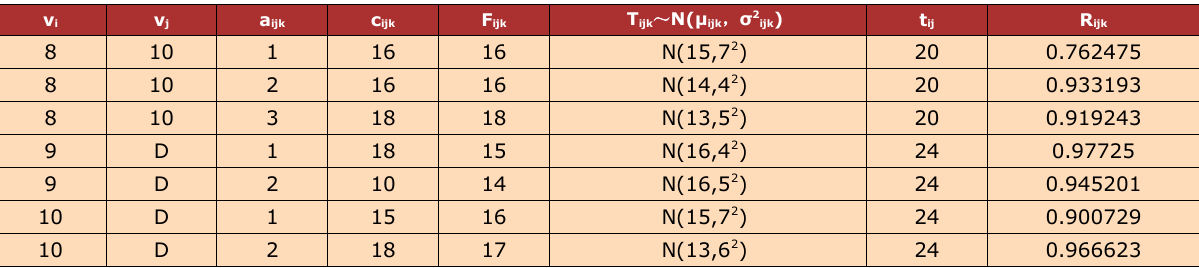
Table 2. The data of arcs for the 12-node problem